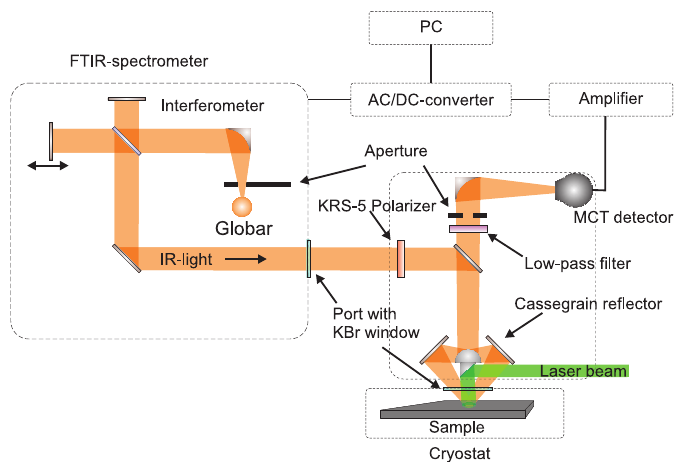
Figure 23. Sketch of the optical setup including the laser beam to excite the TTF-CA sample. The setup consists of three main parts (dashed lines). The centerpiece of the setup is the Fourier-transform infrared spectrometer containing the electronics as the A/D-converter and amplifier, but also the Globar light source, the interferometer with the beamsplitter and several mirrors to deflect the light beam. The second part is the infrared microscope which is attached to the spectrometer. There, the light is focused on the sample by a 15 × Cassegrain reflector. Furthermore, a polarizer and bandpass filter can be mounted in the microscope. The MCT detector is placed at the end of the light beam. Adapted from Peterseim and Dressel [84].